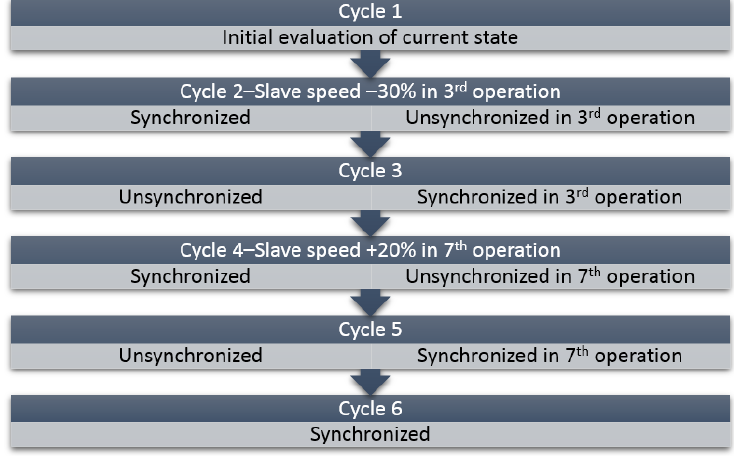
Figure 9. Brief summary of Experiment 2a results.